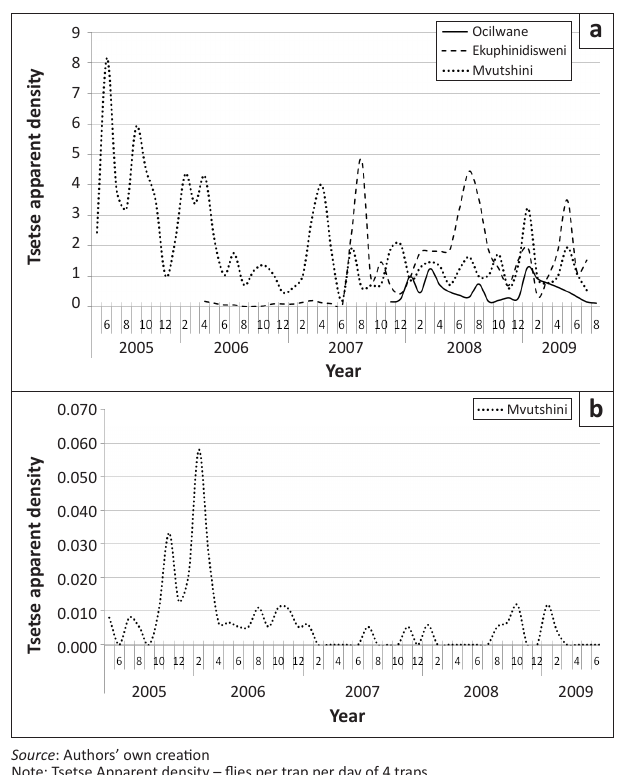
FIGURE 2: Tsetse populations of, (a) Glossina brevipalpis and (b) Glossina austeni at Ekuphindisweni, Mvutshini and Ocilwane